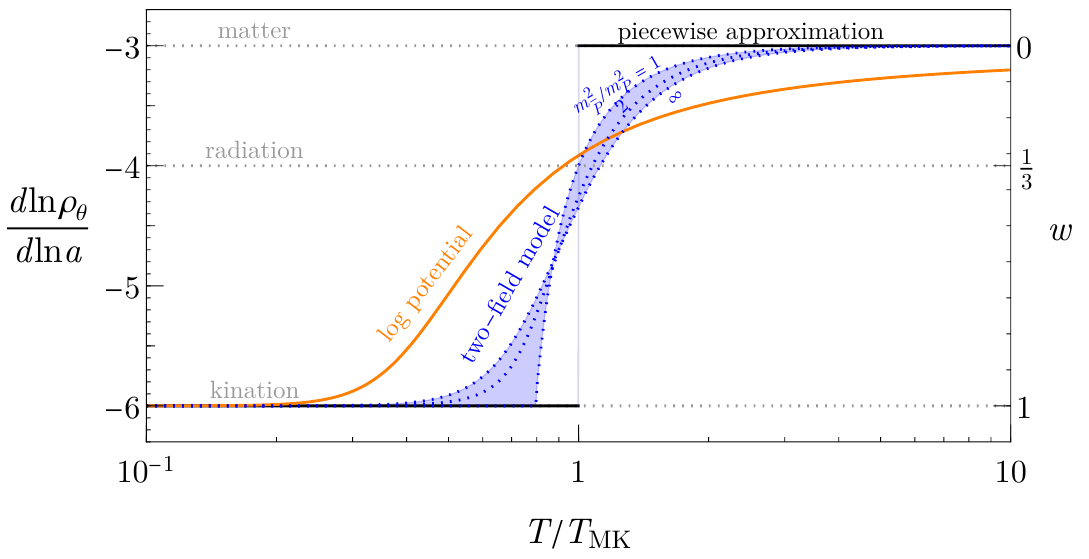
Figure 1 . Scaling evolution of the energy density ρ with scale factor a (left axis) as well as the equation of state w (right axis) as a function of temperature in units of T MK , the transition temperature from matter to kination. The colored curves are for the two-field model (blue) and the logarithmic potential (orange), whereas the step function (black) is the piecewise approximation we employ in the remainder of the paper. For the two-field model, we show the blue dotted curves for different ratios of the soft masses of the two fields ¯ P and P , and the blue shading indicates the entire possible range of the